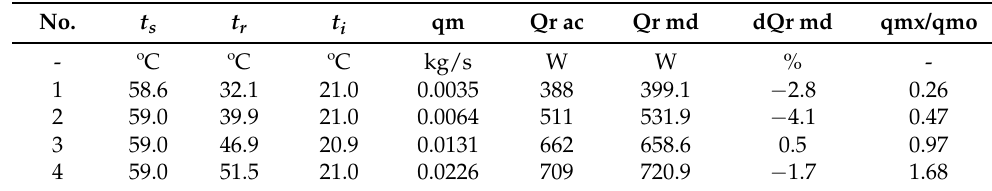
Table 6. The comparison between the measurement results and the simulation calculations Convector Radiator type-8RS , t s = 58.9 ◦ C.